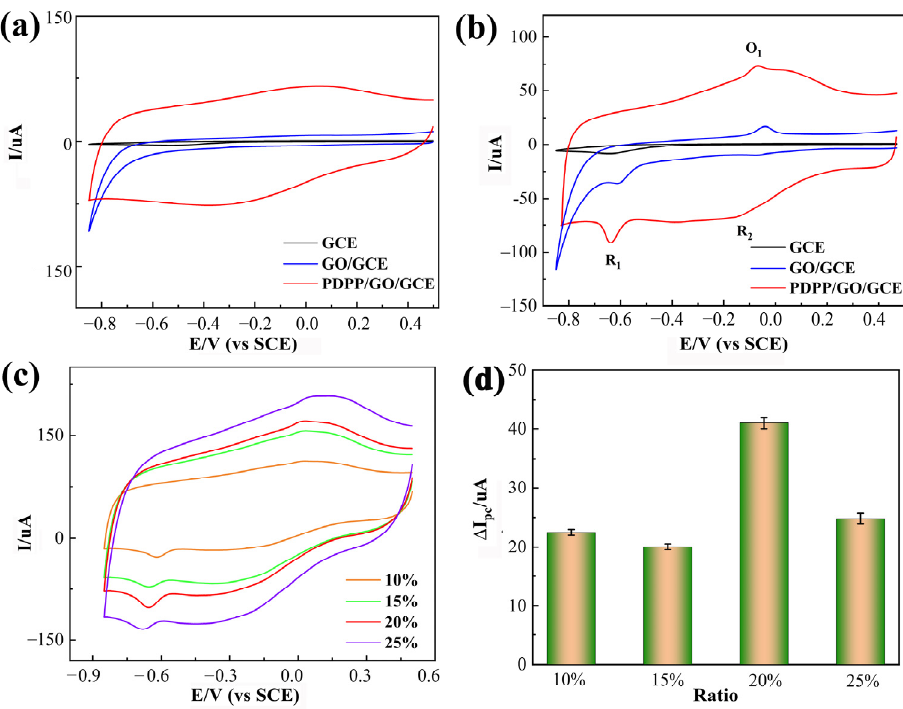
Figure 5. CVs of different electrodes (GCE, GO/GCE, PDPP/GO/GCE) in 0.1 M PBS (pH 6.5) without ( a ) and with ( b ) 0.01 mM chloramphenicol; ( c ) CVs of PDPP/GO/GCE at different ratios, 10%, 15%, 20%, and 25%, in 0.1 M PBS (pH 6.5) containing 0.01 mM chloramphenicol; ( d ) absolute peak reduction current ( ∆ I) vs. the ratio from the CVs. All scan rates: 50 mV/s.